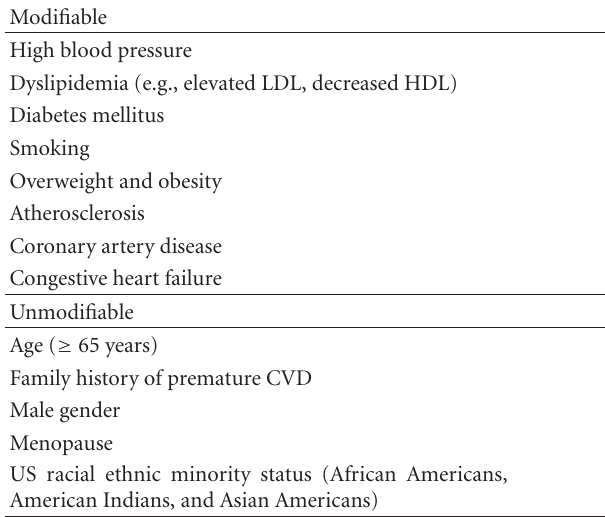
Figure 1: Algorithm for a comprehensive approach to hypertension control in disadvantaged persons with chronic kidney disease (CKD). SBP; systolic blood pressure; DBP; diastolic blood pressure; BB; beta blocker; ACEI; angiotensin converting enzyme inhibitor; ARB; angiotensin receptor blocker; CV; cardiovascular; CCB; calcium channel blocker; eGFR; estimated glomerular filtration rate. Adapted from Martins et al. [27]. Table 2: Cardiovascular disease risk factors associated with CKD